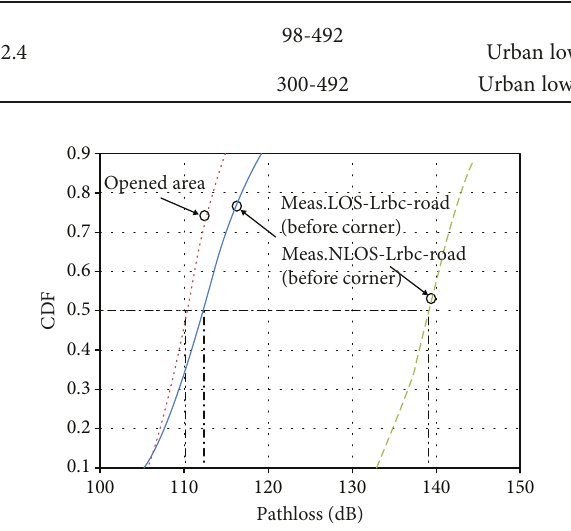
Table 1: Pathloss coe ffi cient on the route that travels before the corner along the road (at site-speci fi c). Frequency (GHz)